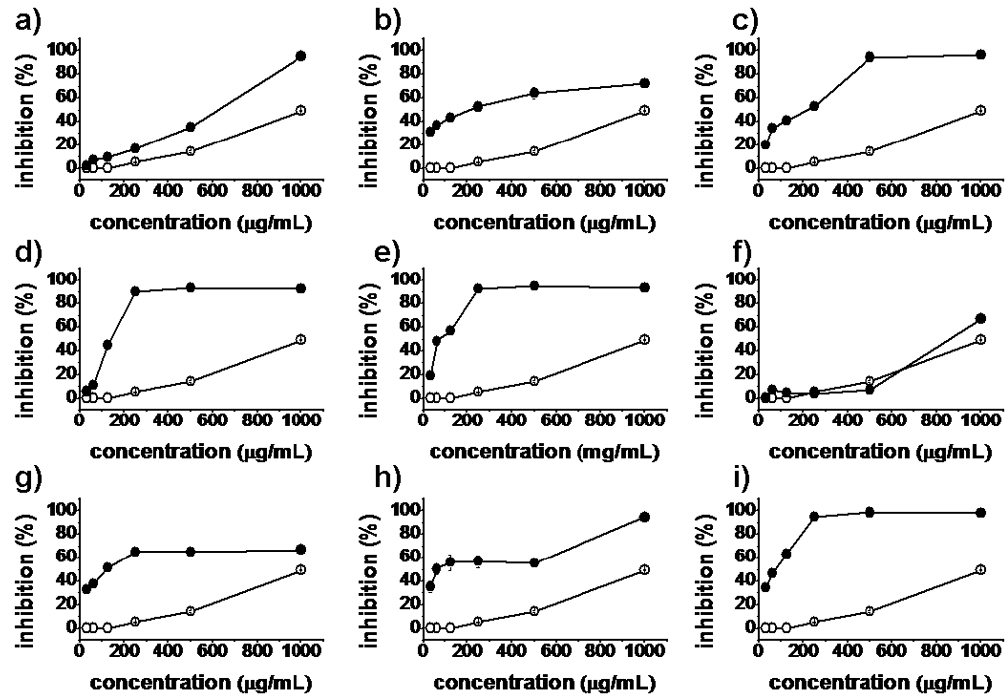
Figure 5. Inhibition percentages of 5a – i ( a – i , respectively) against HepG2 cells ( 4 ) at concentrations of 31.25, 62.5, 125, 250, 500, and 1,000 μ g/mL. Matrine ( ), synthesized compounds ( ). Results are expressed as the mean ± SD of data obtained from three independent